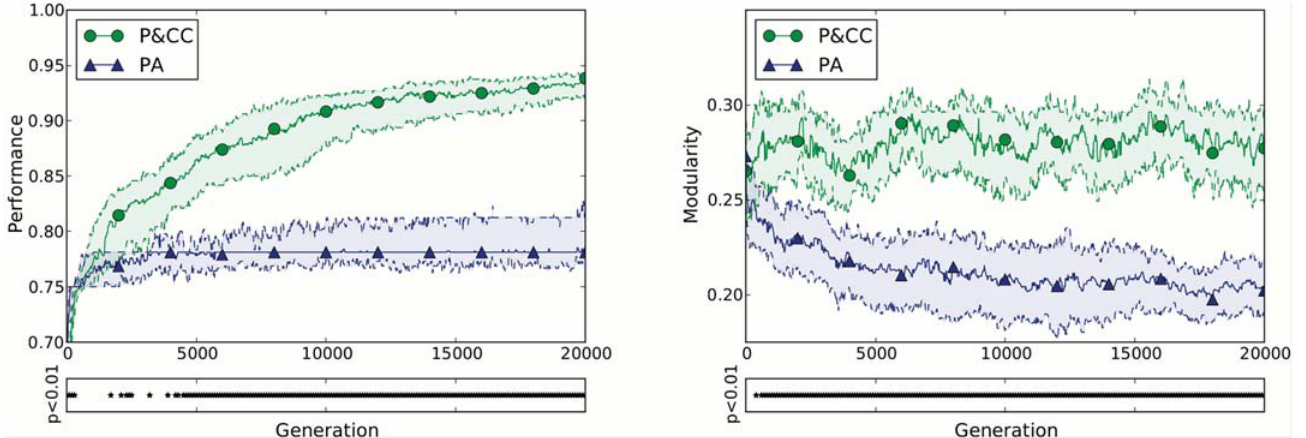
Fig 4. The addition of a cost for network connections, which is present only in the P&CC treatment, significantly increases performance and modularity. Modularity is measured via a widely used approximation of the standard Q modularity score [23, 57, 65, 67] (Methods). For each treatment, the median from 100 independent evolution experiments is shown ± 95% bootstrapped confidence intervals of the median (Methods). Asterisks below each plot indicate statistically significant differences at p < 0.01 according to the Mann-Whitney U test, which is the default statistical test throughout this paper unless otherwise